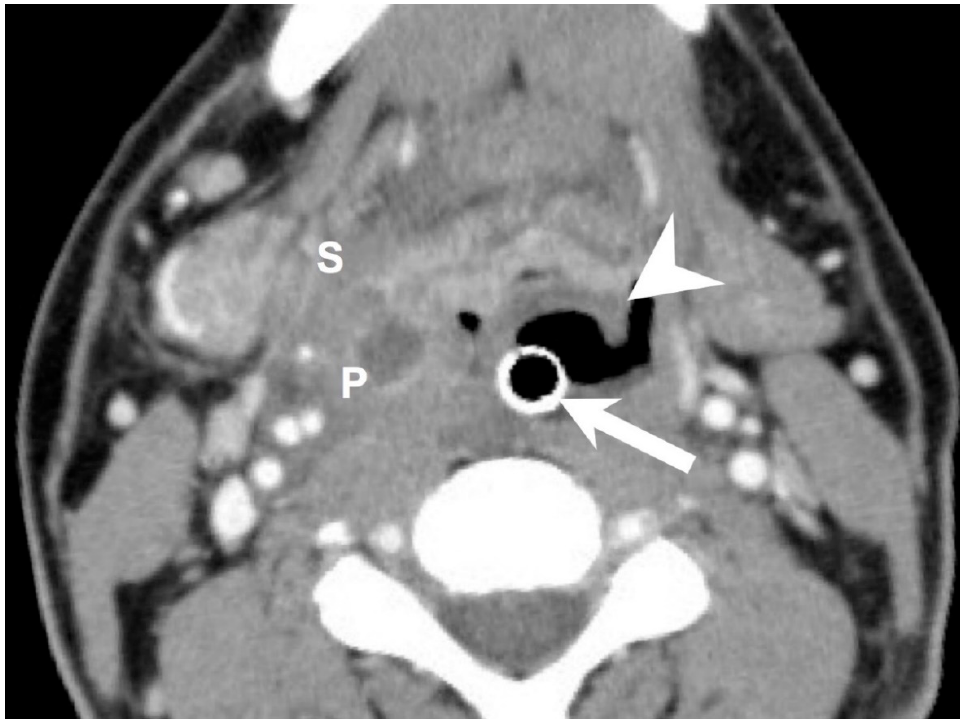
Figure 2. Axial CT view of an intubated patient with concurrent acute epiglottitis and multiple deep neck infections. Abscesses were detected in the parapharyngeal space and submandibular space. Arrow: endotracheal tube insertion; arrowhead: swollen and inflammatory epiglottis; P: parapharyngeal space; S: submandibular space. 300 × 300 DPI.